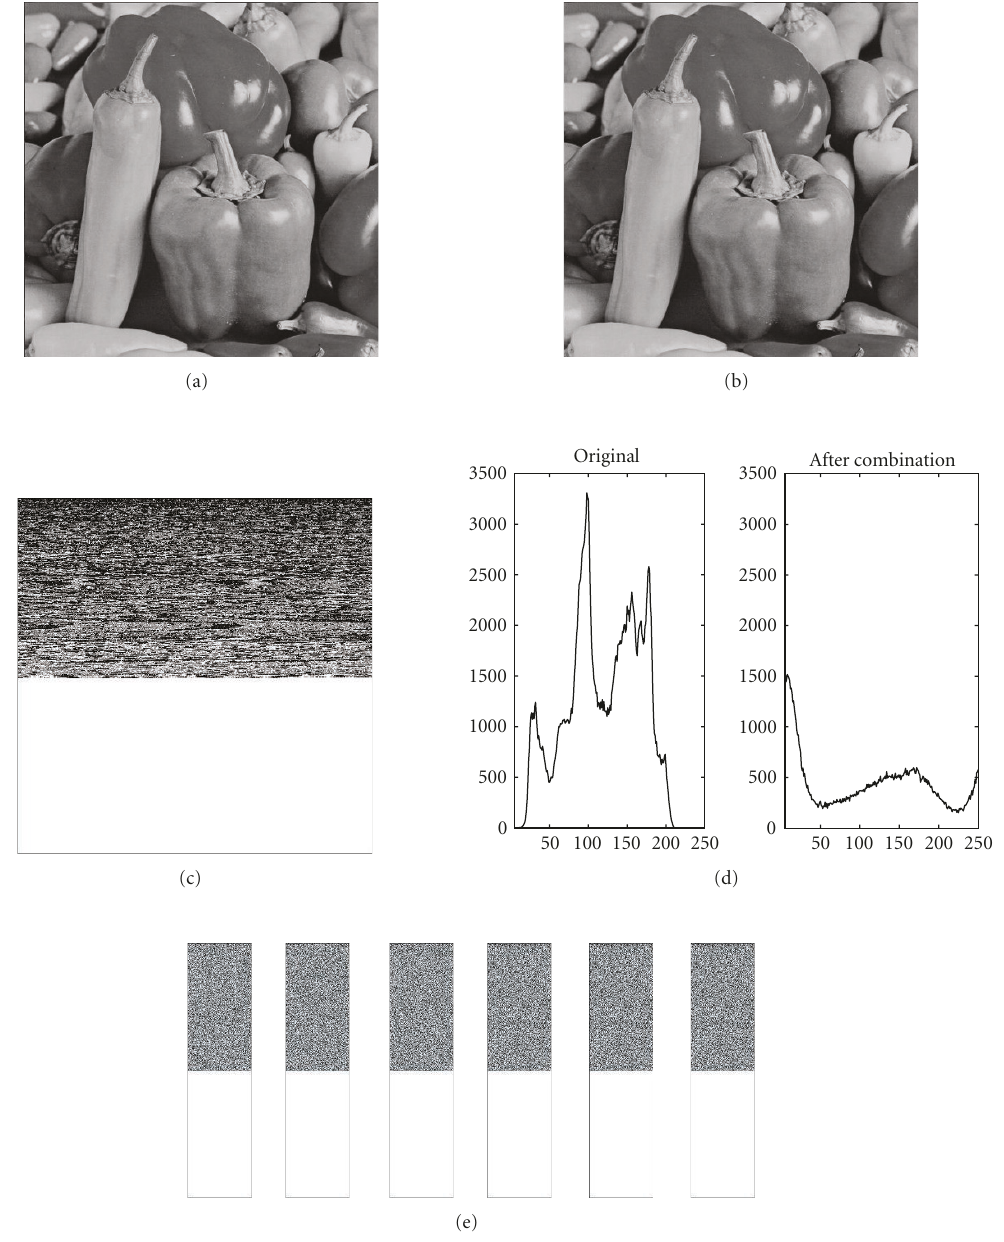
Figure 6: Illustration of the results of various processing phases of the Peppers image: (a) the original Peppers image, (b) the reconstructed image using four out of six shadows in (e), (c) the result of the preprocessing stage, (d) histogram of the original image and histogram of the combination coe ffi cient image resulted from the preprocessing, and (e) shadows generated by the proposed method with r = 4 and m =